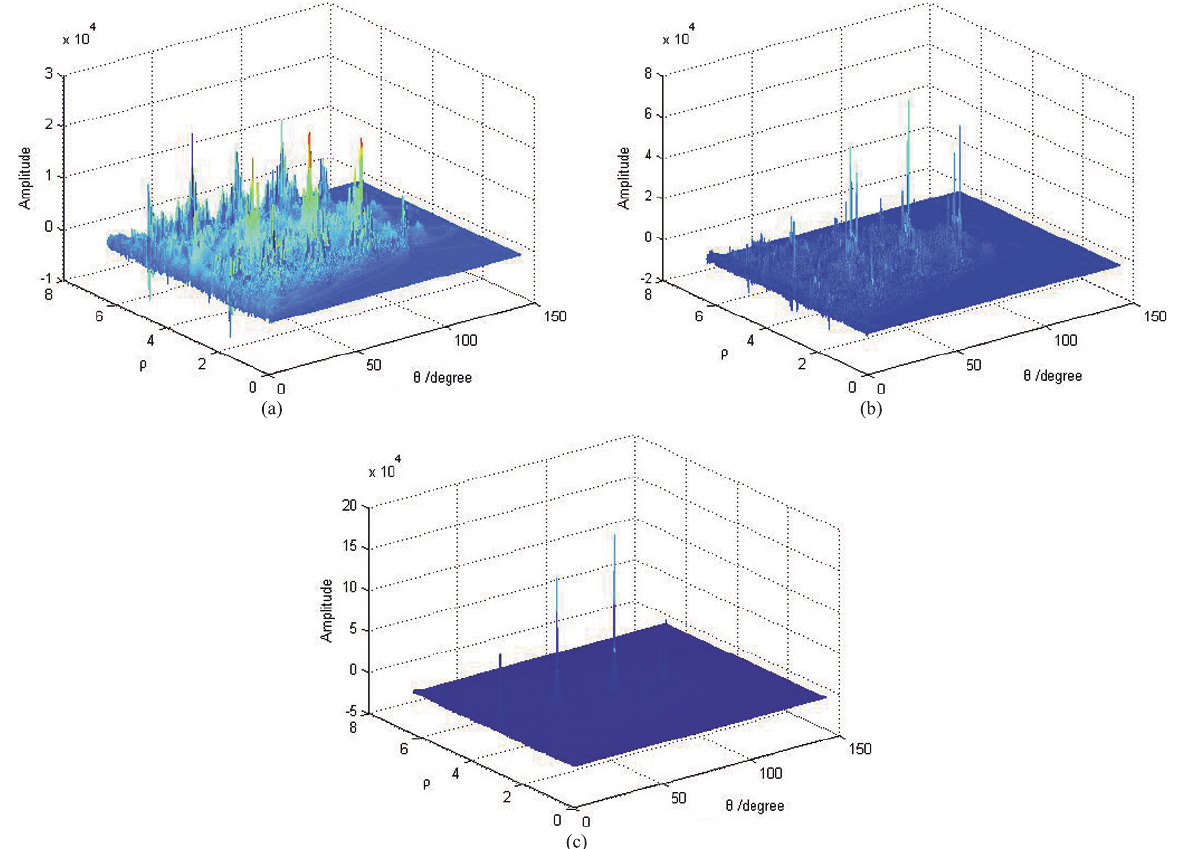
Fig. 6. Feature extraction of gears fault signal (a) Based on WHT (b) Based on the improved WHT (c) Feature extraction before adding a small